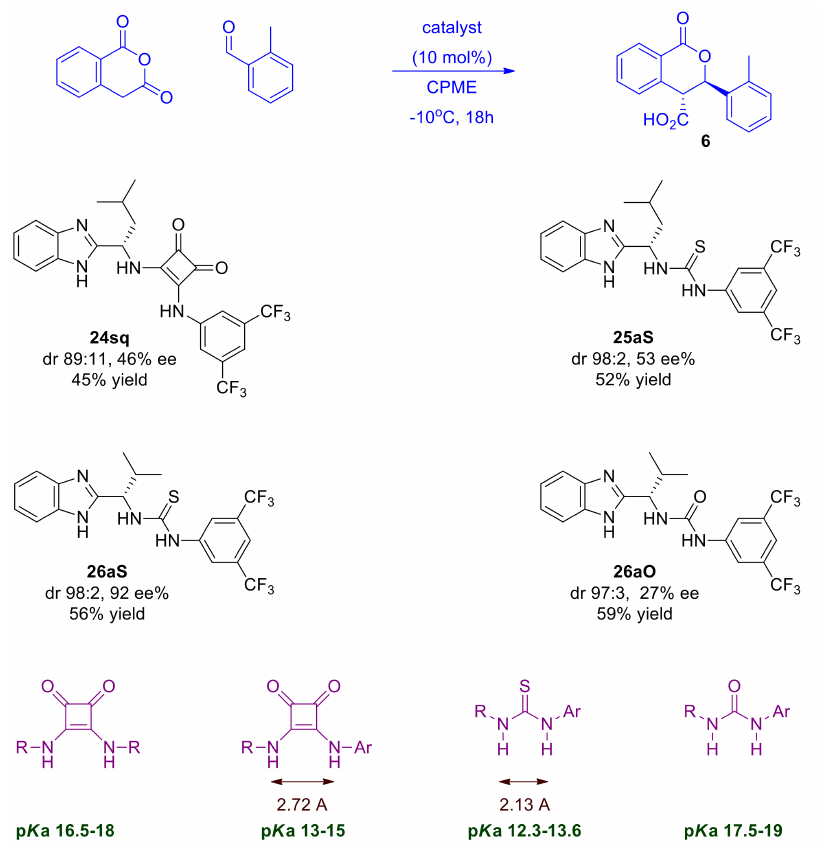
Scheme 9. Screening of different types of dual BIMAH-based organocatalysts in the Pinder